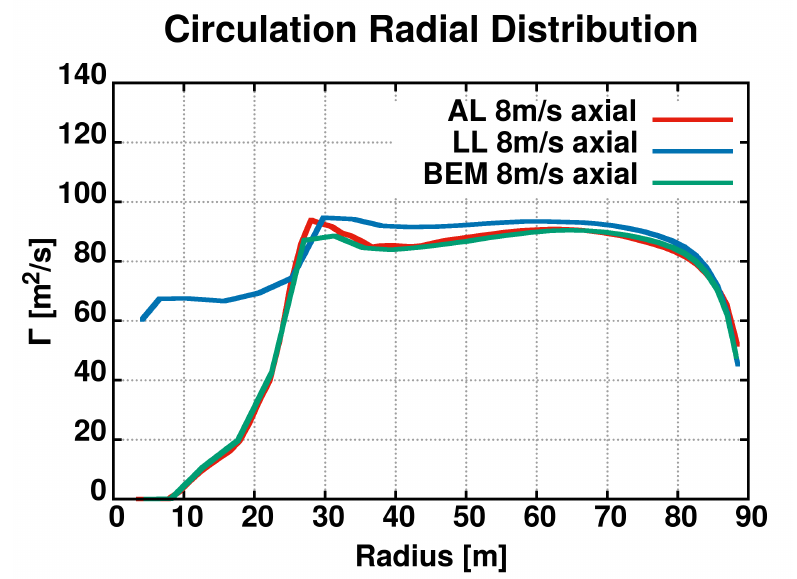
Figure 21. Circulation radial distribution at 8 m/s axial wind speed. Averaging over the final revolution of the simulation.